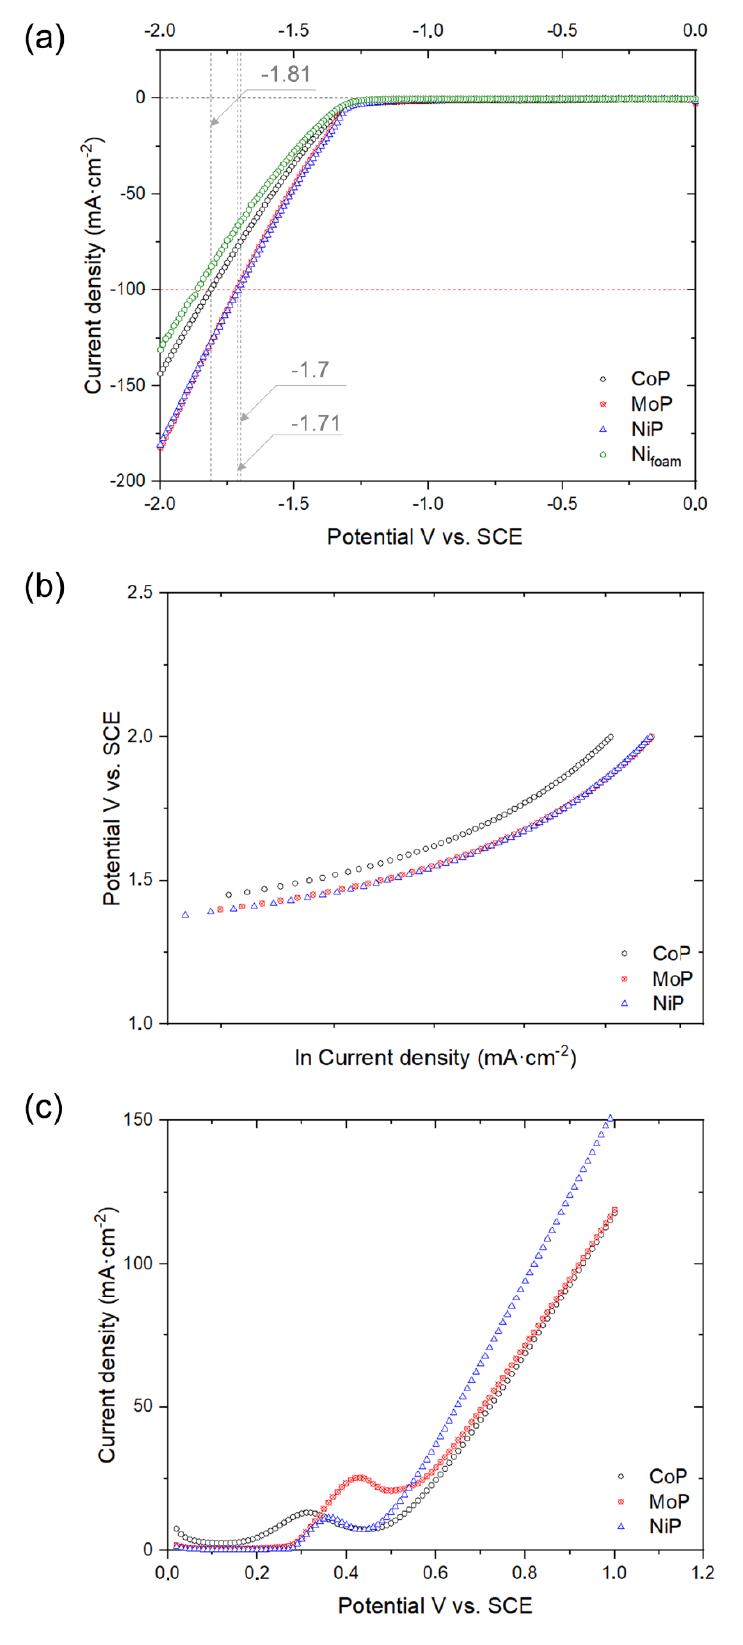
Figure 5. LSV representation for CoP, MoP, and NiP. ( a ) HER representation, ( b ) Tafel slope, and ( c ) OER